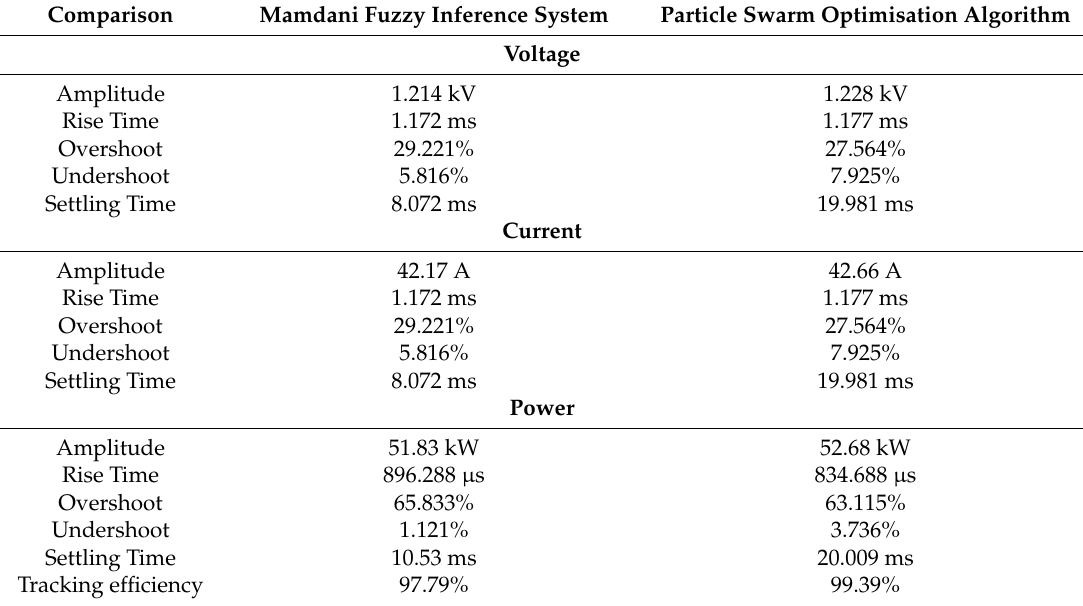
Table 4. Characteristic